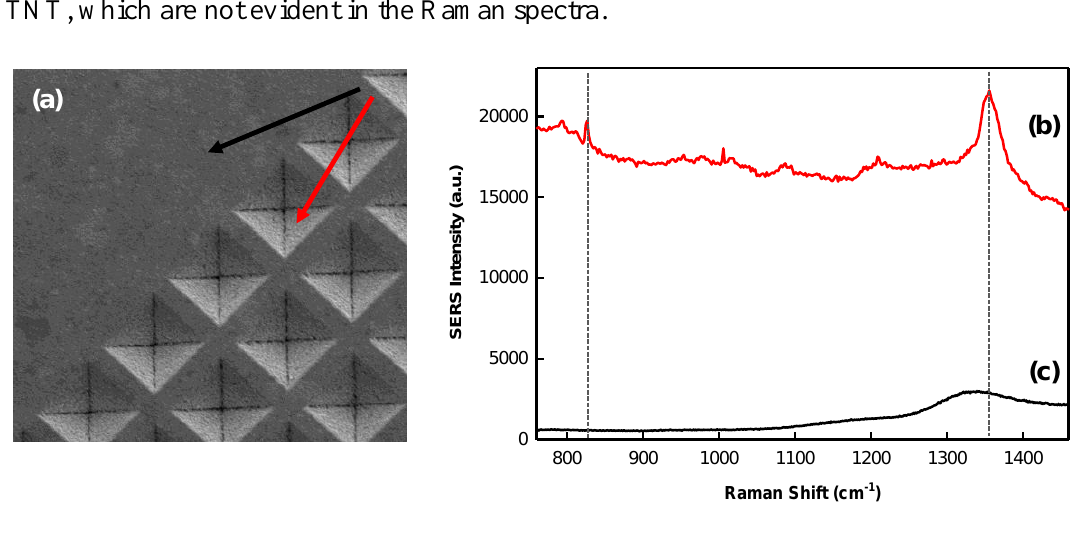
the SERS-active patterned grid area. The black and red arrows illustrate the measurement areas for the Raman and SERS spectra, respectively. SERS (b) and Raman (c) spectra recorded for a TNT-doped xerogel film. The vertical lines indicate the peaks related to TNT, which are not evident in the Raman